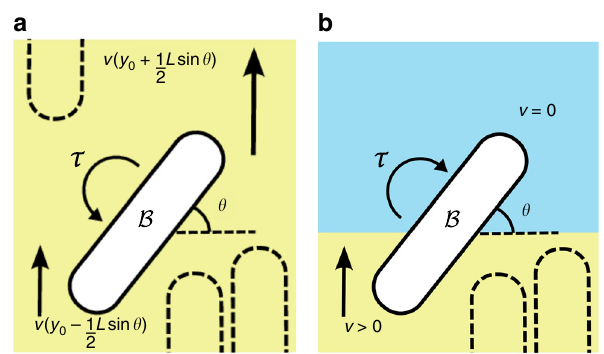
Fig. 5 Growth-induced ordering. a Schematic illustration of a bacterium B in the bulk of colony, with the surrounding bacteria orientated to the vertical as exempli fi ed by the dotted shapes. The growth-induced velocity gradients in the surrounding bulk produce a torque on B , which rotates it into the same orientation as its neighbours. b A bacterium at the boundary of the colony experiences a steep velocity gradient of the opposite direction with respect to the case in a : the associated cellular fl ow rotates B into a tangential orientation to the